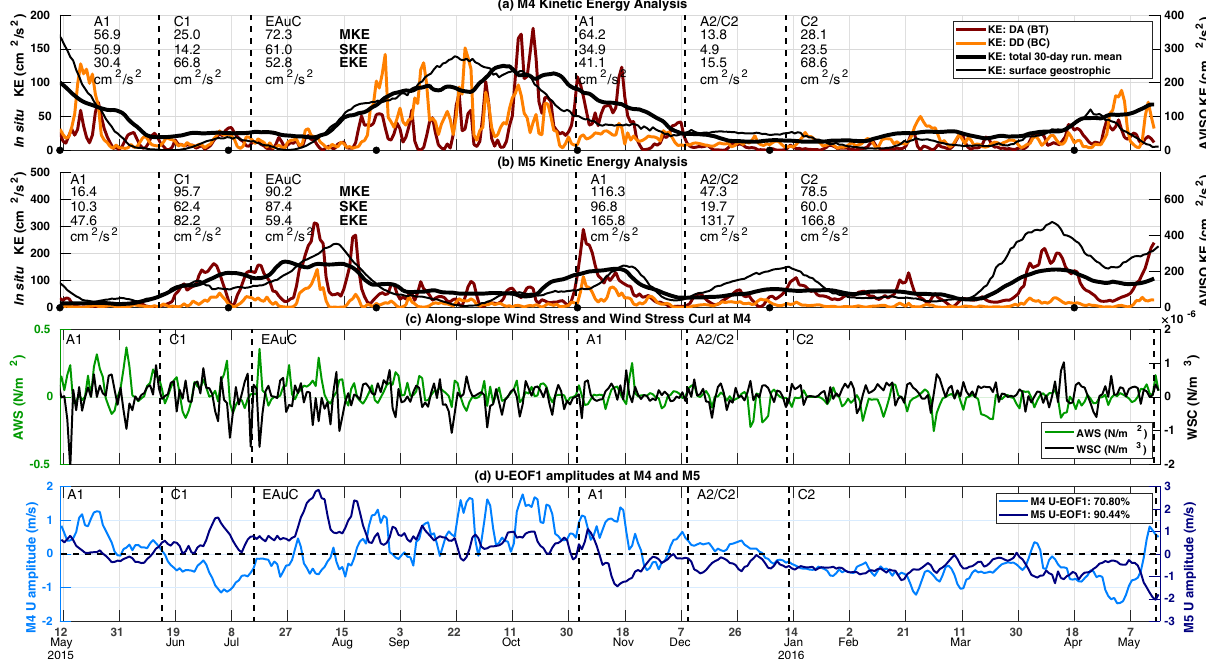
Figure 6. Time series of water column average kinetic energy (KE) divided into depth-averaged (DA) (dark red) and depth-dependent (DD) (orange) at M4 ( a ) and M5 ( b ). The 30-day running mean of the in situ KE (bold black line) and the daily AVISO geostrophic KE (thin black line—right y axis) are also shown. The KE mean (MKE), standard deviation (SKE), and eddy kinetic energy (EKE) for each mesoscale event are also shown. The EKE was computed using the anomalies related to the average from the EAuC period (16/6 to 2/11/2015) (Fig. 3). ( c ) time series of AWS (green) and WSC (black) at M4. ( d ) U-EOF1 amplitude time-series at M4 (light blue— left y axis) and M5 (dark blue—right y